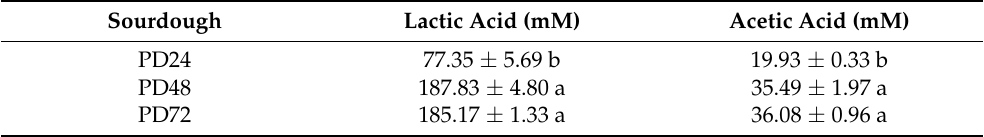
Table 3. Lactic and acetic acid concentrations in the aqueous extracts from poolish-type sourdough (PD) fermented with Lactiplantibacillus plantarum NRRL B-4496 for 24, 48, or 72 h. Sourdough Lactic Acid (mM) Acetic Acid (mM) PD24 77.35 ± 5.69 b 19.93 ± 0.33 b PD48 187.83 ± 4.80 a 35.49 ± 1.97 a PD72 185.17 ± 1.33 a 36.08 ± 0.96 a